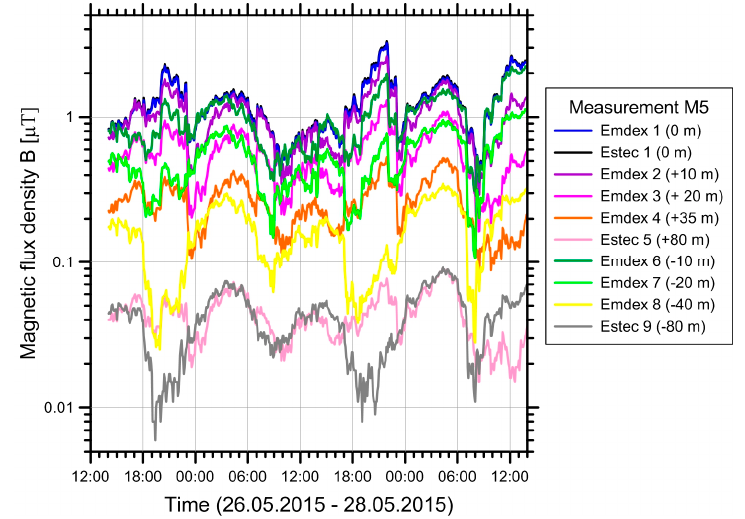
Figure 10. Measured magnetic fields during measurement M5 for all devices. The devices Emdex 1 and Estec 1 were measuring at the same measurement point and the curves of these devices are indistinguishable in the figure.